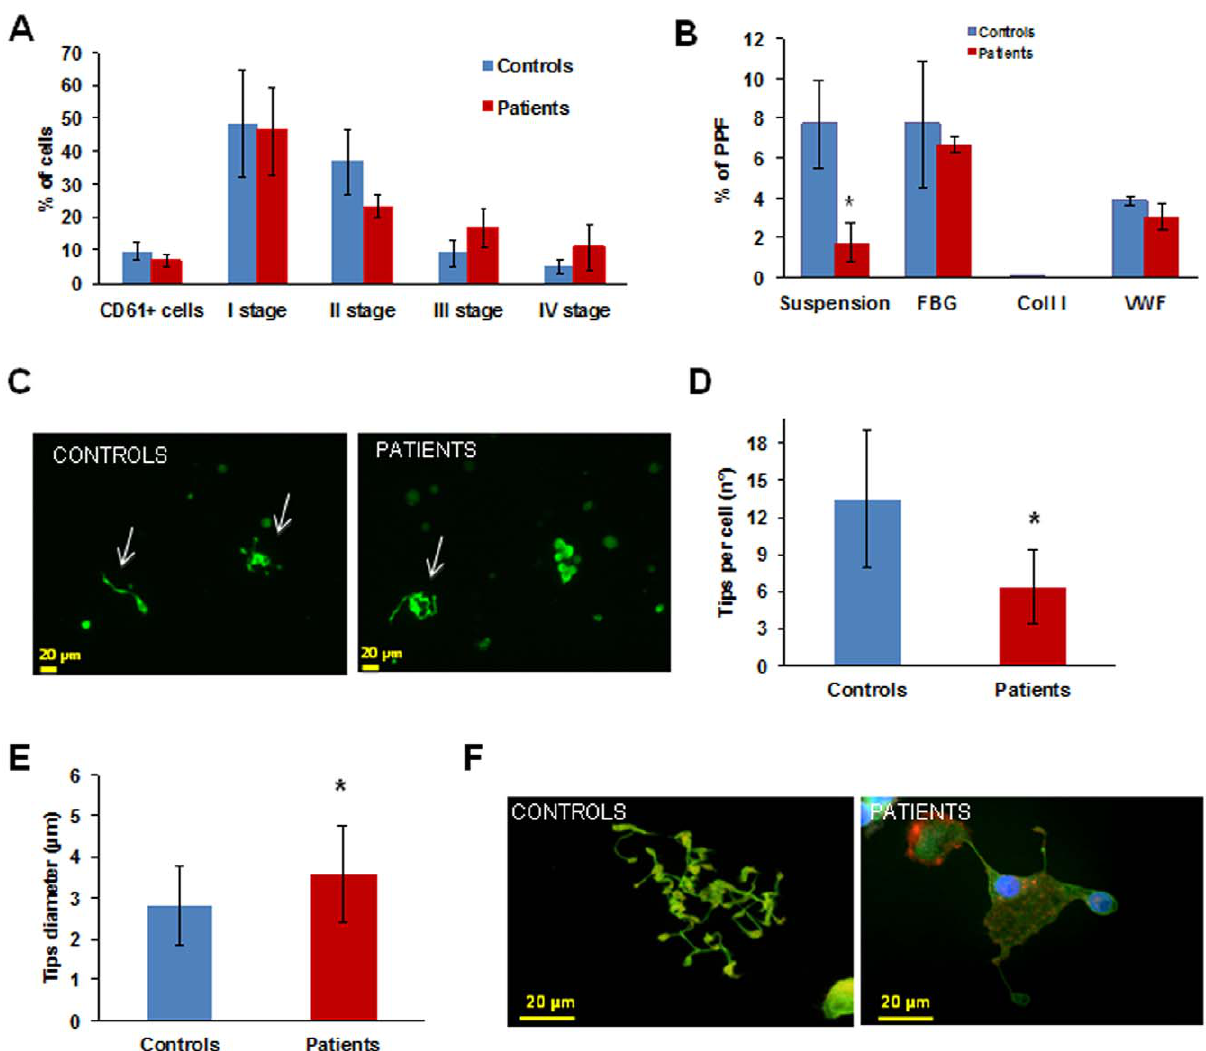
Figure 1. Megakaryocyte differentiation and proplatelet formation. (A) Megakaryocyte maturation stages of patients did not differ from those of controls. (B) Proplatelet formation (PPF) from patient megakaryocytes in suspension was drastically reduced. When megakaryocytes were plated on type I collagen proplatelet formation was absent, similar to controls, while on fibrinogen and von Willebrand factor the number of megakaryocytes extending proplatelets was normal. *p , 0.05 vs control. (C) Representative pictures of proplatelet formation in suspension, in a control subject and a patient (20 6 magnification). Arrows indicate pro-platelets, only one developing proplatelet is evident in the patient sample. (D, E) Patient megakaryocytes extended a reduced number of proplatelets with abnormal characteristics: a spread shape with shorter than normal proplatelet shafts and tips significantly decreased in number and larger in size than those of controls. *p , 0.05 vs control. (F) Representative images of megakaryocytes from patients and controls releasing proplatelets upon adhesion to